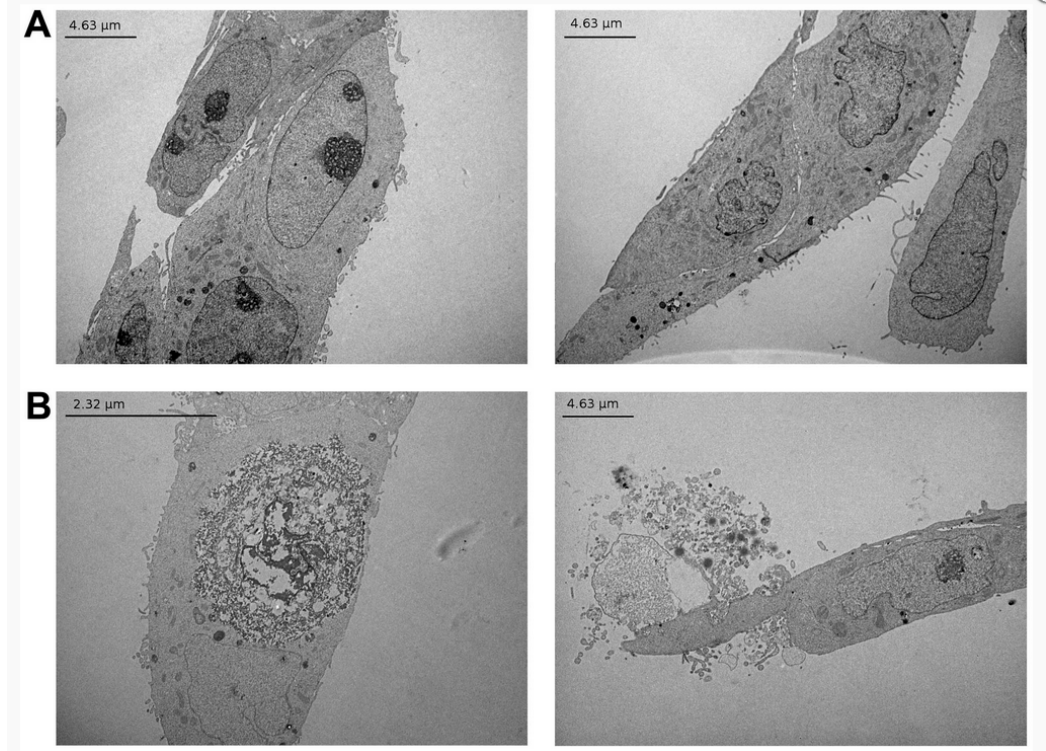
Figure 3. Transmission electron micrographs representative of MCF-7 cells. Confluent cells (60–70%) were treated with 6 μ M of α -tomatine for 4 h. Images of transverse sections of the cells are shown. ( A ) Control cells, ( B ) α -tomatine-treated cells. The treated cells show the disintegration of both the outer and nuclear membranes, but no typical morphologic signs of apoptosis. Reproduced from reference [55].